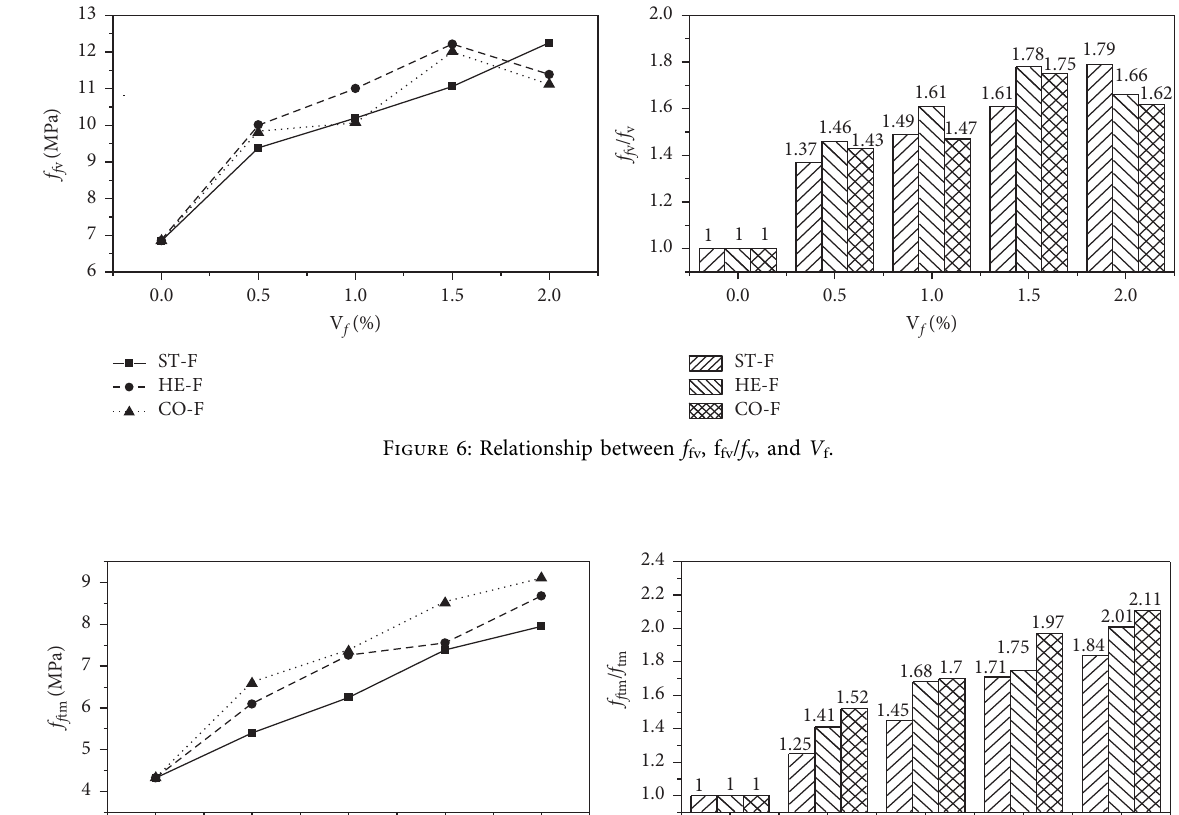
ftm , f ftm / f tm , and V f .